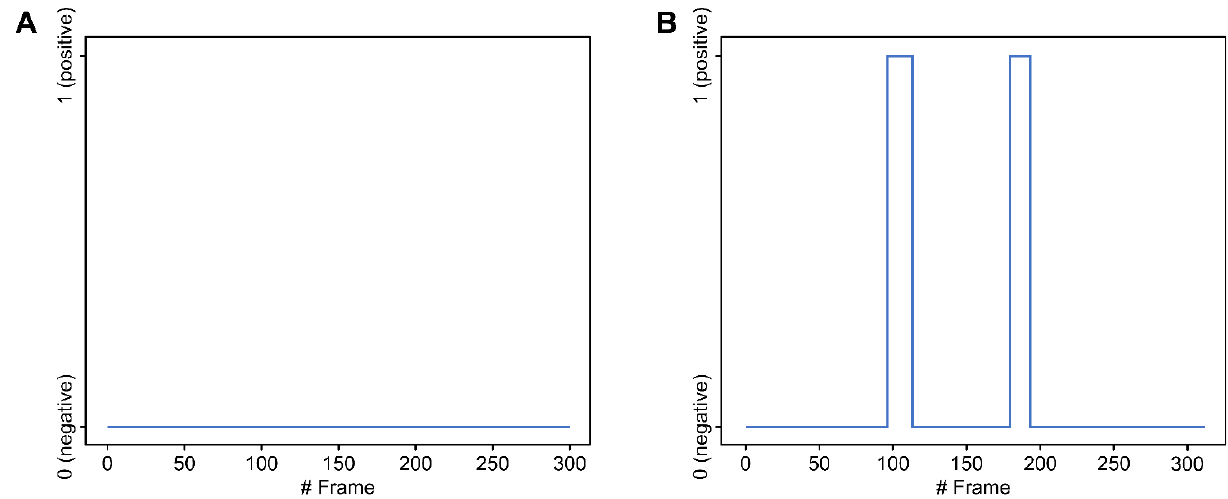
Figure 2. Example output of the deep learning model represented as histograms: ( A ) No laryngeal penetration or aspiration was detected in any frame of the video. ( B ) Laryngeal penetration or aspiration occurred in approximately the 100th to 115th frames and the 180th to 200th frames of the video.